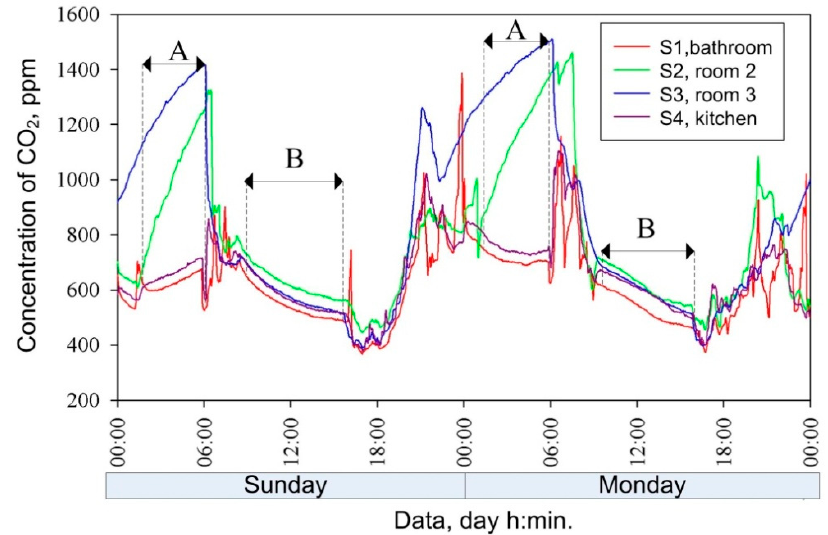
Figure 4. Measured carbon dioxide concentration in apartment I; A—period of build-up concentration; B—period with decay concentration.